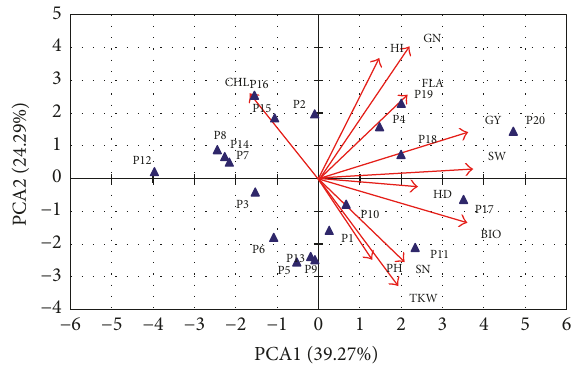
Figure 1: Principal Component Analysis (PCA) projections on axes 1 and 2, accounting for 63.56% of total variation, for 20 F 4 popula- tions of bread wheat.